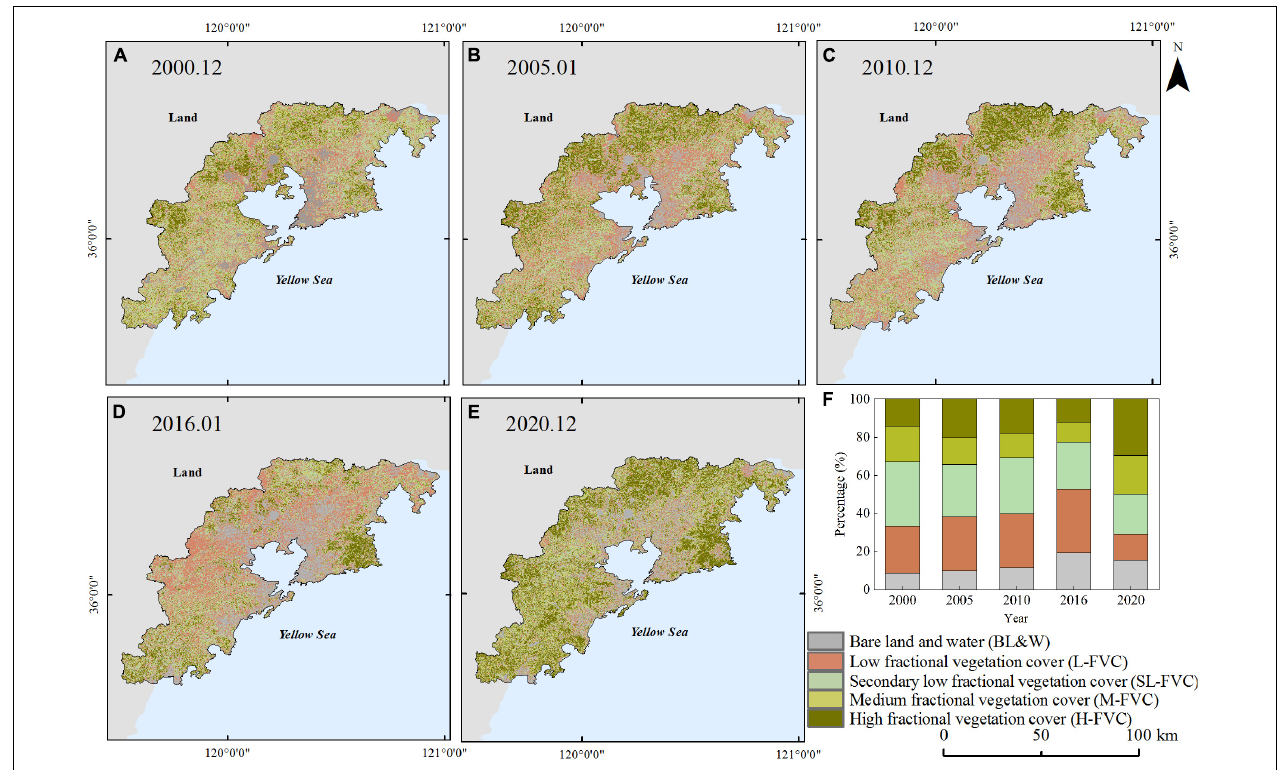
FIGURE 5 | Classification of fractional vegetation cover in winter from 2000 to 2020 (A) 2000.12, (B) 2005.01, (C) 2010.12, (D) 2016.01, (E) 2020.12, and (F) the percentage of different classification from 2000 to